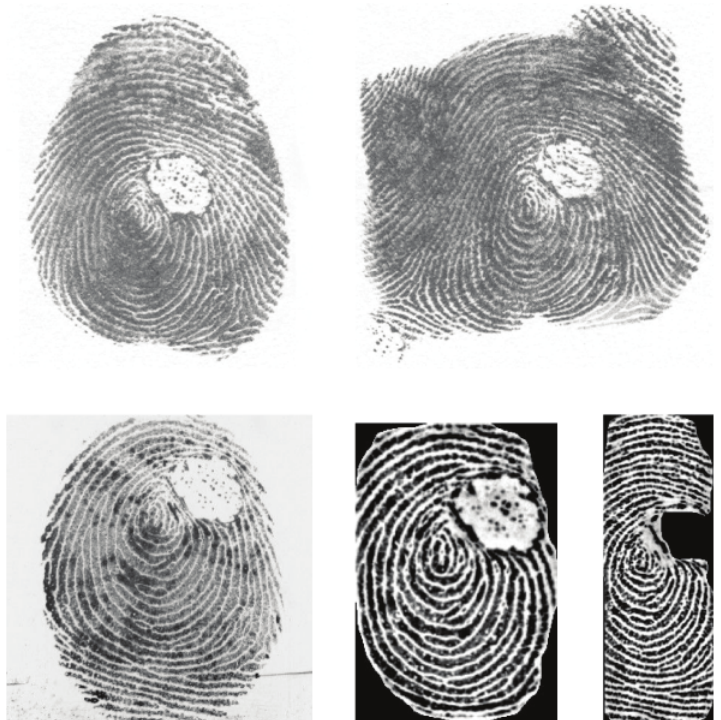
Figure 21: Fingerprints with warts—verruca vulgaris (same person).